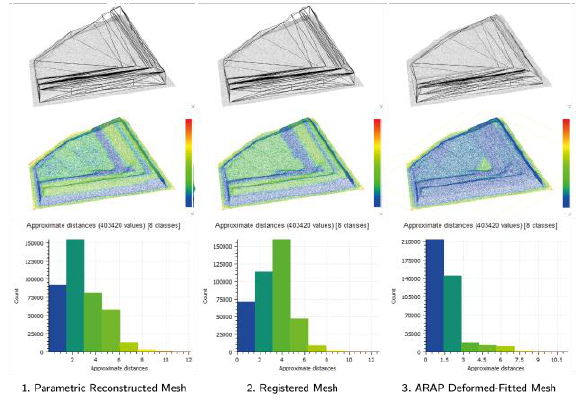
Figure 8. Accuracy evaluation of the 3D parametric fitted modelling. Point cloud to mesh distance.